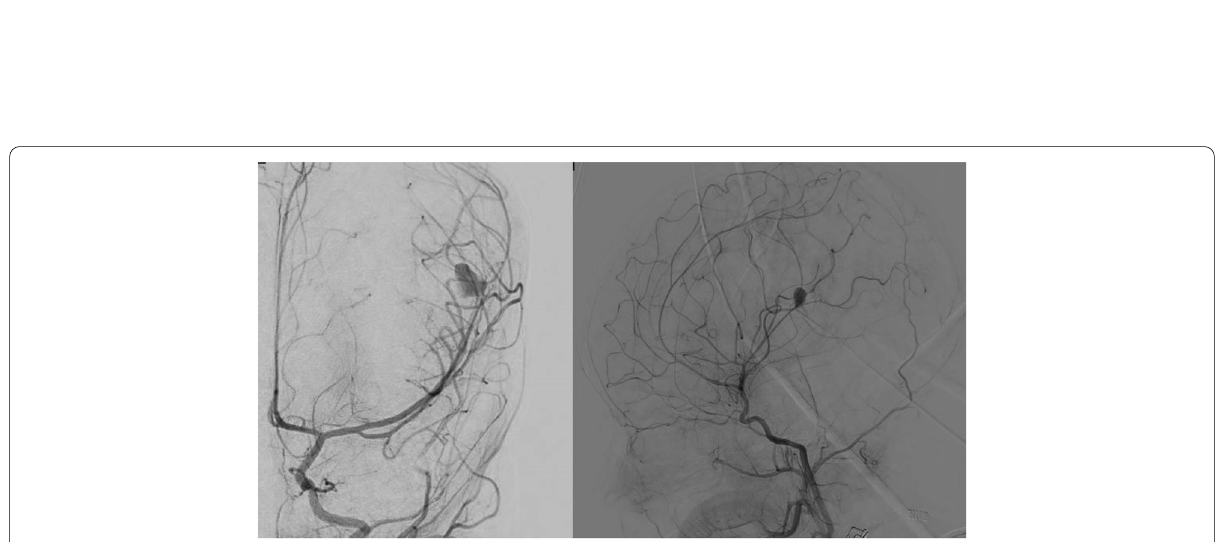
Fig. 2 Cerebral arteriography of case 1. Distal aneurysm of the left MCA, 4